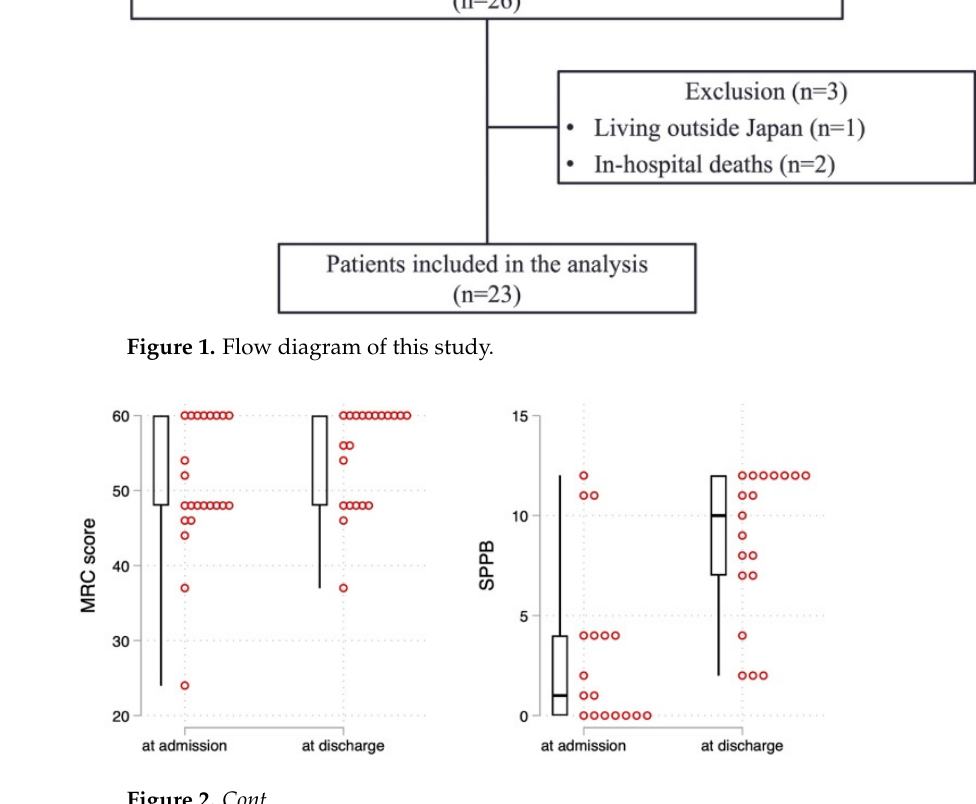
Figure 2. Box and dot plots of changes in physical function and ADL from hospital admission to discharge. MRC = medical research council, SPPB = short physical performance battery, IMS = in- tensive care unit mobility scale, FSS-ICU = functional status score for the ICU. Figure 3. Prevalence of sarcopenia defined as SPPB < 9 points. 3.4. Association of SPPB at Discharge with Background Factors and Laboratory Data The relationship between SPPB scores at discharge and background factors and la- boratory data at admission was evaluated using Spearman’s correlation coefficient. The SPPB scores demonstrated a signi fi cant correlation with WBC (Spearman’s rho = − 0.473, p = 0.041) and C-reactive protein (CRP; Spearman’s rho = − 0.468, p = 0.044), and a significant trend with PaO 2 /FiO 2 (Spearman’s rho = 0.429, p = 0.067) and age (Spearman’s rho = 0.409, p = 0.083) (Figure 4).